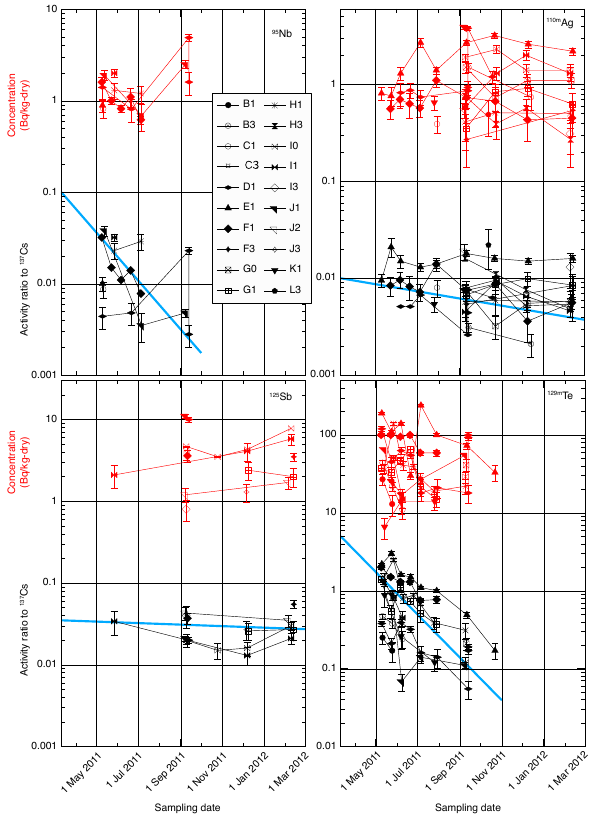
Fig. 13. Temporal variations of 95 Nb, 110 m Ag, 125 Sb, and 129 m Te concentrations (red symbols) and their corresponding 137 Cs activity ratios (black symbols) in sediments. The blue lines indicate theoret- ical decay curves for the nuclides at arbitrary initial